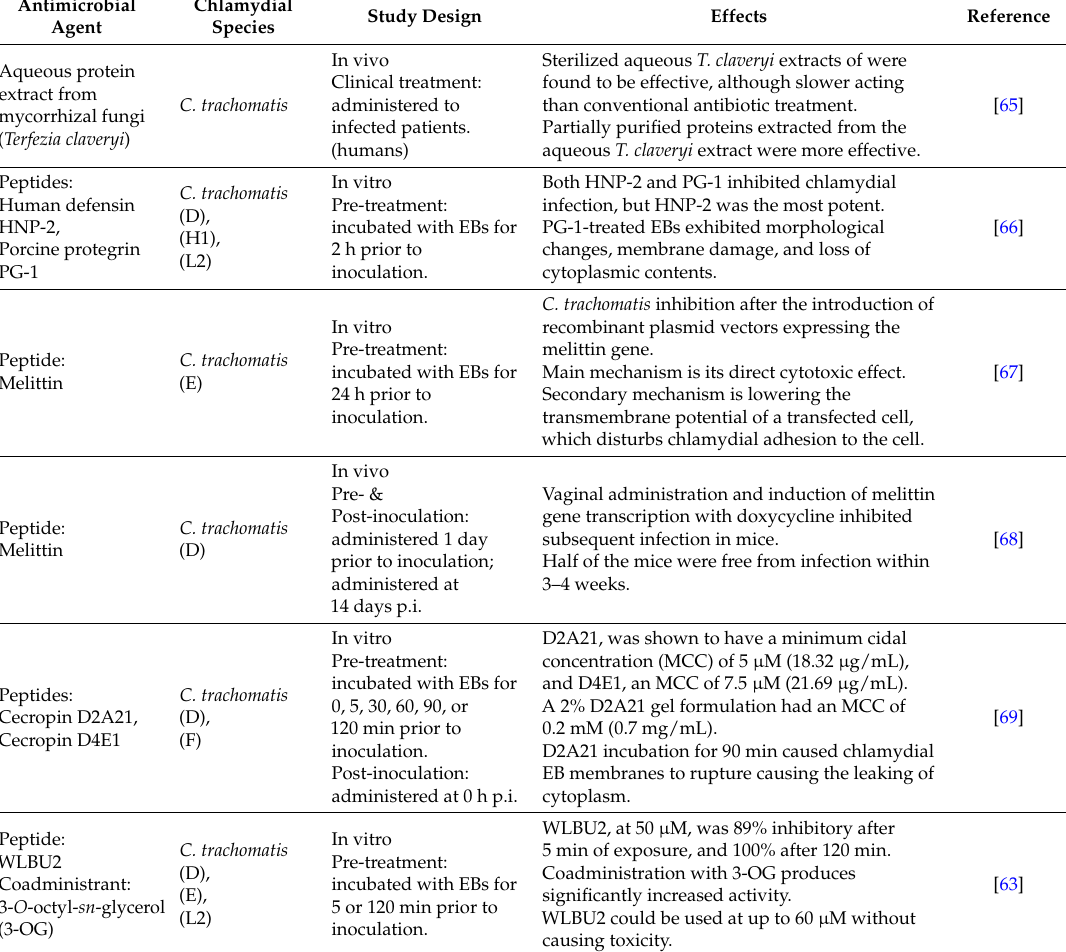
Table 4. Past studies exploring antichlamydial properties of proteinaceous compounds. Antimicrobial Chlamydial Study Agent Species